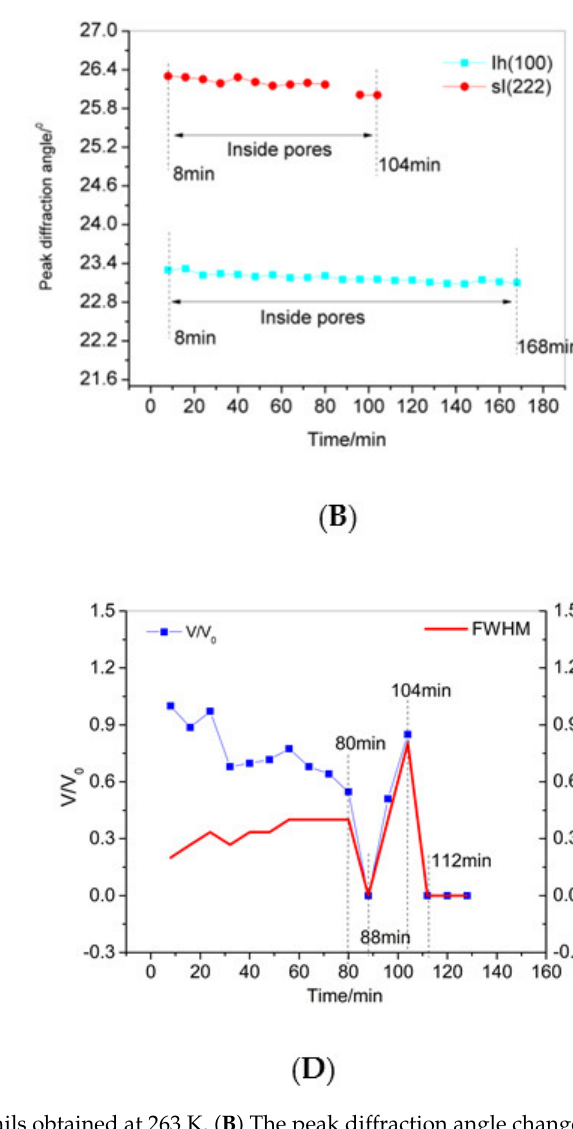
Figure 4. Dissociation process at 263 K. ( A ) XRD pattern details obtained at 263 K. ( B ) The peak diffraction angle change of sI(222) and Ih(100) with respect to the time calculated from the XRD patterns. The peak diffraction angle is not shown when the peak intensity was 0. ( C ) The volume change of hydrate or ice Ih, V/V 0 , and the peak intensity change of sI(222) or Ih(100) inside the pores, I/I0. ( D ) The volume change of the hydrate, V/V 0 , and the FWHM change of sI(222). The FWHM change is the ratio of the FWHM of sI(222) to the FWHM of sI(222) at the initial time (8 min).